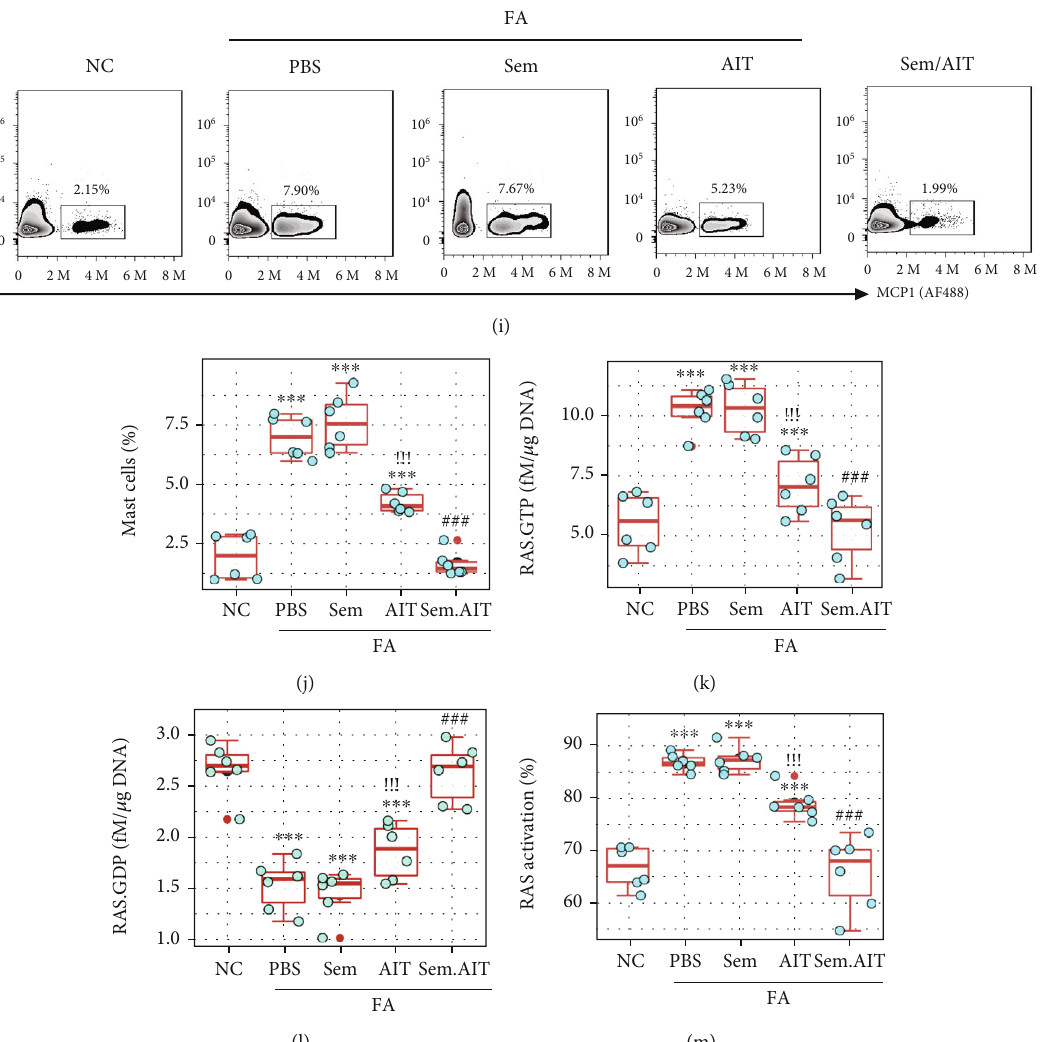
Figure 6: Assessment of sema3A e ff ects on promoting AIT. FA mice were treated with sema3A (Sem, in short) or/and AIT or PBS. (a) Diarrhea mice during 2h after allergen challenge. (b) Core temperature changes at 30min after allergen challenge. (c) Serum allergen- speci fi c IgE (sIgE) levels. (d – f) Gut lavage fl uid (GLF) Th2 cytokine levels. (g, h) GLF EPO and mMCP1 levels. (i) Gated plots show mast cell frequency in LPMCs. (j) Summarized mast cell frequency in LPMCs. (k – m) RAS activation status in mast cells of the intestine. The data of boxplots are presented as median (IQR). ∗∗∗ p < 0 : 001 (ANOVA+Dunnett ’ s test) compared with the naïve control (NC) group. !!! p < 0 : 001 ( t test), compared with the PBS group. ### p < 0 : 001 ( t test), compared with the AIT alone group. Each bubble presents data obtained from one mouse. The data of (i) are from one experiment that represent 6 independent